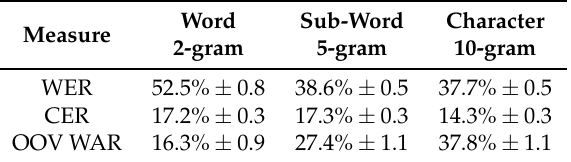
Table 4. Summary of the best results in terms of WER, CER and OOV WAR for the RNN system. Measure